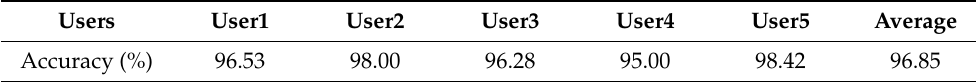
Table 5. The AP-DCN recognition accuracy for different